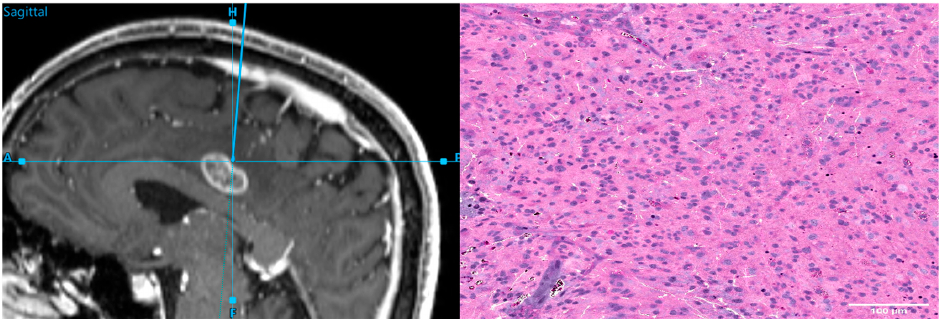
Figure 9. Intraoperative navigation during resection of a brain tumor ( left ) and the corresponding stimulated Raman histology ( right excision and processing of the samples [166].